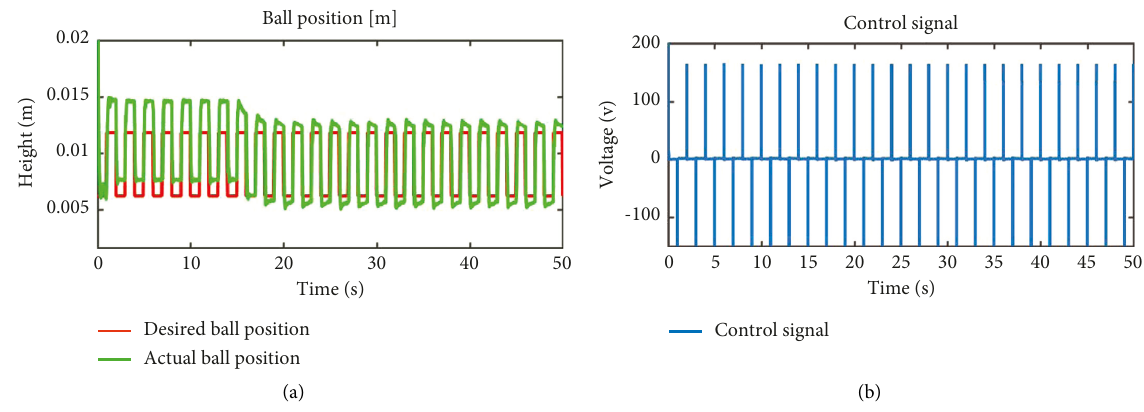
Figure 8: SQUARE output and control signal for the LQR controller.